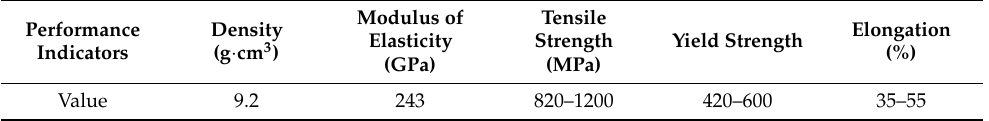
Table 5. Experimental parameters.